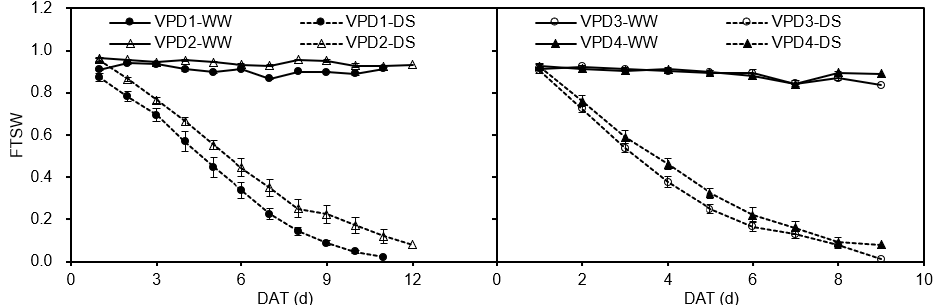
Figure 8. Trends of fraction of transpiration soil water ( FTSW ) at days after imposing treatment stress (DAT) for well-watered (WW) and drought-stressed (DS) potato plants grown under different vapor pressure deficits (VPD) in the greenhouse cells. Error bars indicate the standard error of the mean ( n = 3). DAT denotes days after onset of treatment.